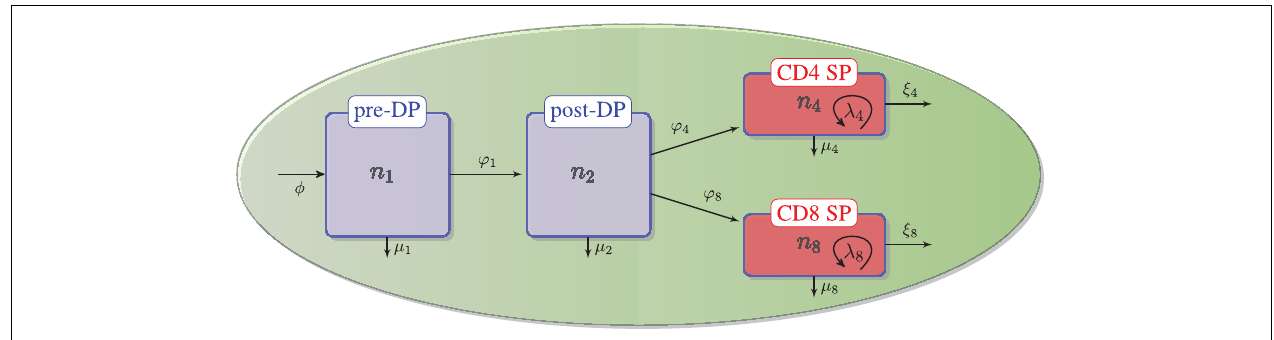
fates: further differentiation into the SP pool as CD4 SPs ( ϕ 4 ), or CD8 SPs ( ϕ 8 ), or death by apoptosis ( µ 2 ). Finally, CD4 or CD8 SP thymocytes have three fates: maturation and exit into the periphery ( ξ 4 ) or ( ξ 8 ), death by apoptosis ( µ 4 ) or ( µ 8 ), or proliferation ( λ 4 ) or ( λ 8